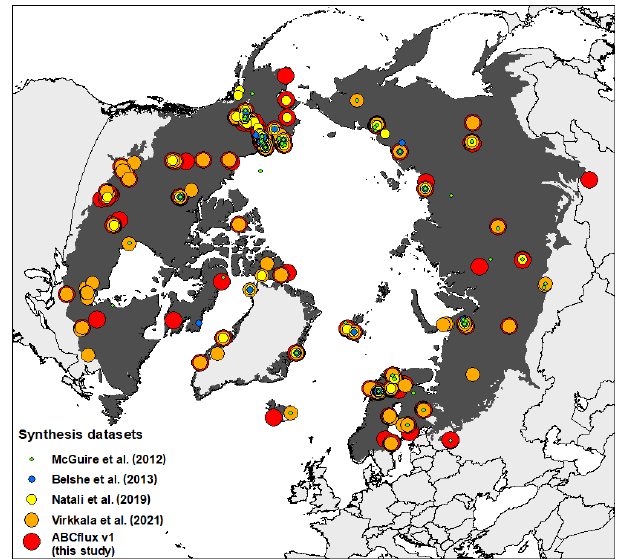
Figure 1. The flux site distribution in previous syntheses that fo- cused on compiling fluxes from high latitudes (McGuire et al., 2012; Belshe et al., 2013; Natali et al., 2019a; Virkkala et al., 2021a; and this study, ABCflux). The Arctic–boreal zone is highlighted in dark grey; countries are shown in the background. Based on the unique latitude–longitude coordinate combinations in the tun- dra, there were 136 tundra sites in ABCflux, 104 tundra sites in Virkkala et al. (2021a), 68 tundra sites in Natali et al. (2019a), 34 tundra sites in Belshe et al. (2013), and 66 tundra sites in McGuire et al. (2012). Observations that were included in previous studies but not in ABCflux represent fluxes aggregated over seasonal, not monthly periods.